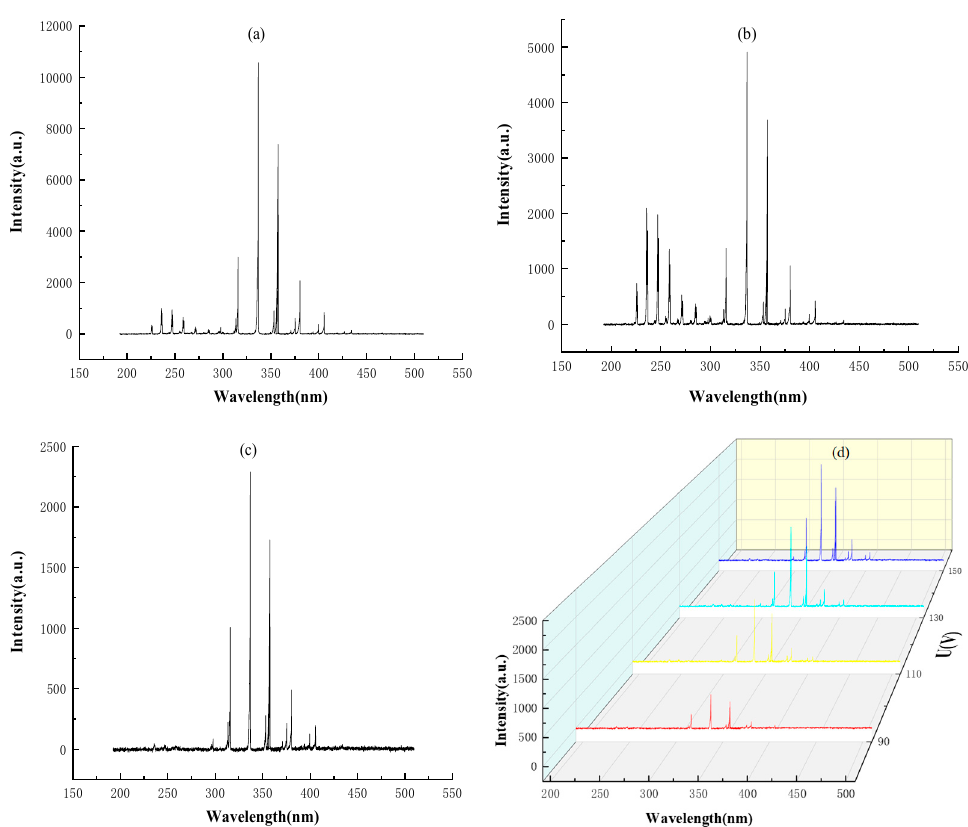
Figure 9. Schematic diagram of emission spectrum distribution: ( a ) Spectrum of N 2 ; ( b ) Spectrum of N 2 /NO/NO 2 ; ( c ) Spectrum of N 2 /O 2 /NO/NO 2 , and ( d ) Spectrum of N 2 /O 2 /NO/NO 2 at different voltages.